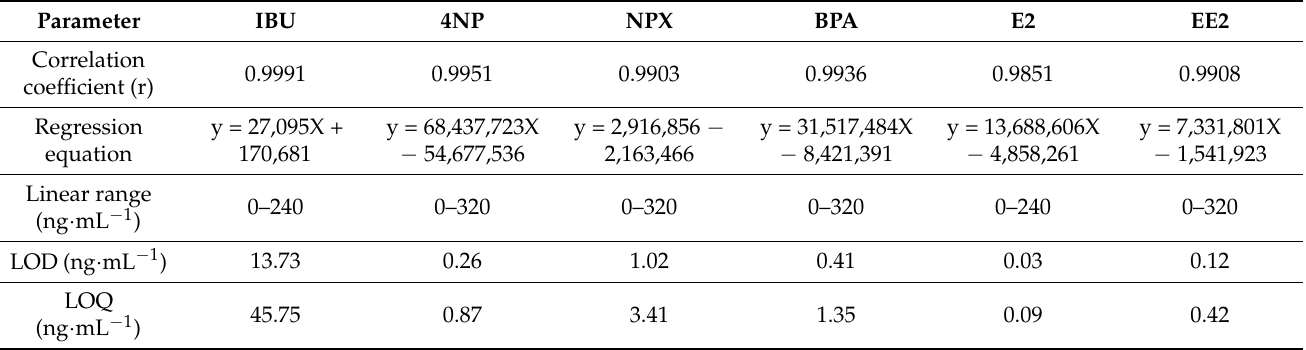
Table 2. Summary of results obtained from the calibration for each of the compounds analyzed.